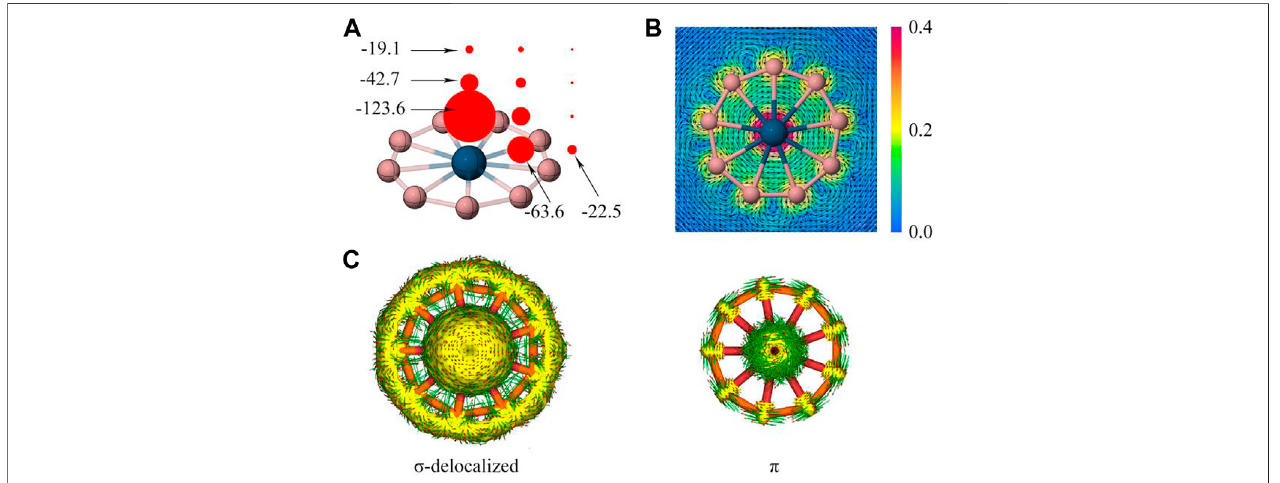
the reported transition-metal-centered borometallic molecular wheel family. Figure 4B displays a gauge including magnetically induced current (GIMIC) map, (Fliegl et al., 2011), where the induced ring current is generated by employing an external magnetic fi eld perpendicular to the molecular plane. The diatropic (clockwise) current comply with the left-handed rule. It is worthy of note that the inner and outside of the peripheral ring both show a diatropic and unidirectional current. This current behavior is similar to the C 18 clusters with double aromaticity ( σ + π ) but sharply different from the benzene ( π aromaticity only), where the ring current show a diatropic inside but paratropic outside of benzene ring.